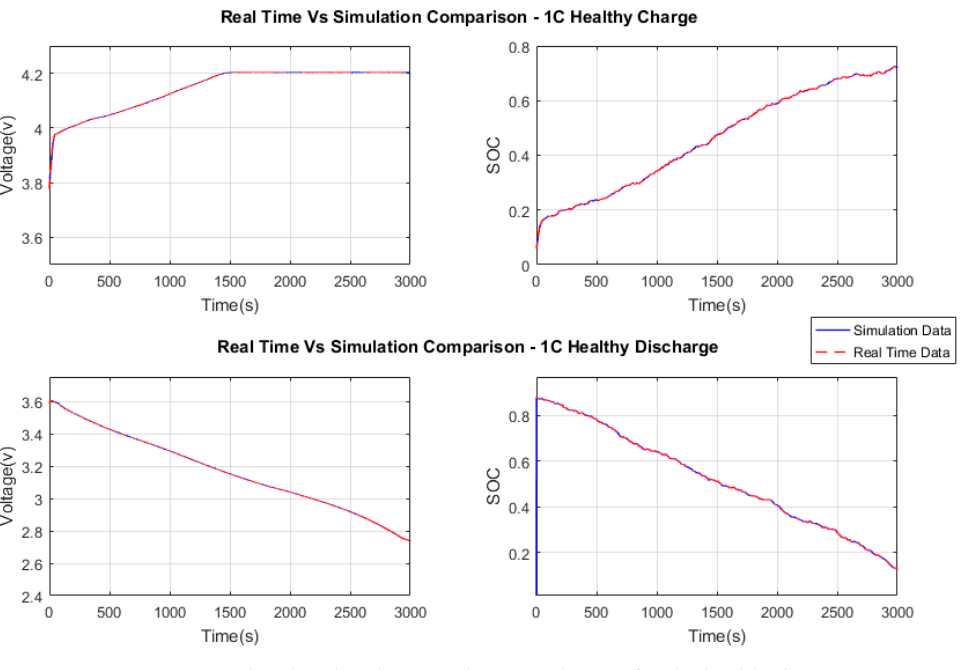
Figure 7. Simulated and real-time voltages and SOCs for the healthy battery.